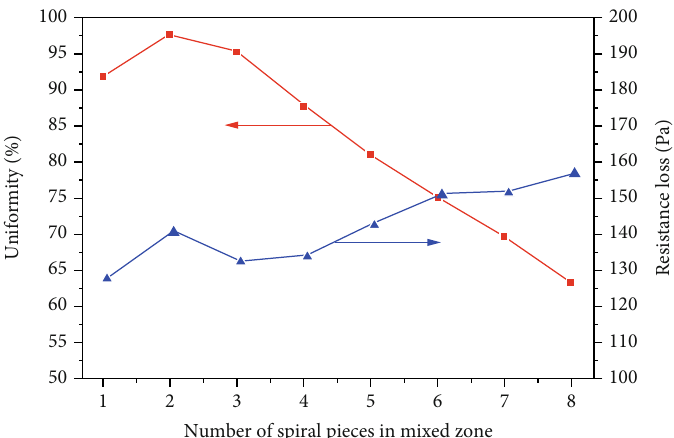
Figure 4: E ff ect of the number of helical blades in mixing zone on fl ow parameters.